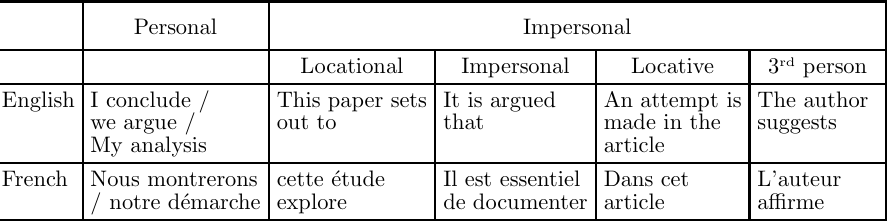
Examples of self-reference